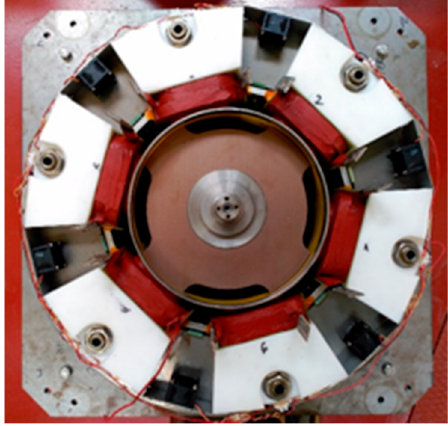
Figure 7. MATLAB-Simulink SRM model layout.